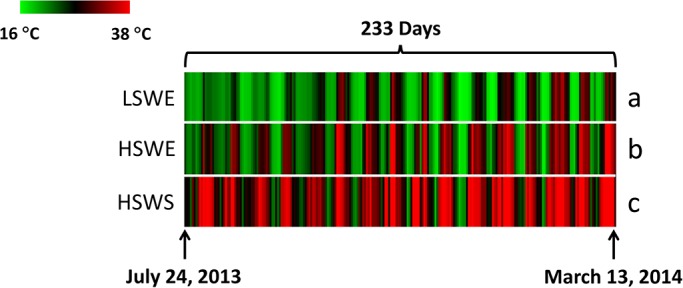
Temperature conditions at
Crystal Cove State Park. Heat-map showing maximum habitat temperatures over a 233-day interval beginning July 24, 2013 at three microhabitats including low-shore-wave-exposed (LSWE); high-shore-wave-exposed (HSWE); and high-shore-sheltered (HSWS). A one-way ANOVA followed by Tukey's test identified significant (P<0.05) differences in maximum habitat temperatures between microhabitats, as indicated by letters (see the Results section for s.e.m. values).